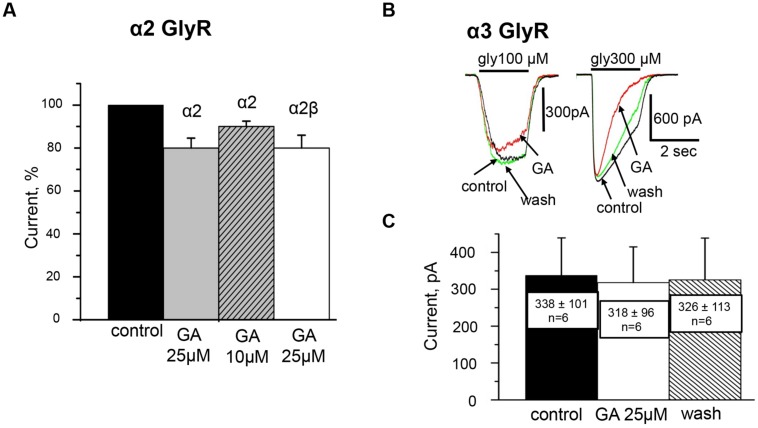
Effect of ginkgolic acid on Igly mediated by homomeric α2 and α3 GlyRs and heteromeric α2/β GlyRs.
(A) Cumulative data. Mean percentage of the effect of 25 μM ginkgolic acid on homomeric α2 GlyRs (light gray), heteromeric α2/β GlyRs (white colomn), and 10 μM of ginkgolic acid on α2 GlyRs (striped). Glycine 30 μM was applied. Data from 7 to 12 cells for each case. (B) Superimposed traces of glycine-evoked currents induced by low for this subunit (100 μM; left) and high (300 μM; right) concentrations of glycine, in control (black), after ginkgolic acid application (red) and after washout (green). Symmetrical ‘CsCl’ pipette solution, Vh = –30 mV. (C) Summary of the data on the effect of ginkgolic acid on the α3-long subunit of GlyR. Mean amplitudes of currents (pA) ± SEM induced by 100 μM glycine from six cells in control (black), during ginkgolic acid application (white), and after washout (striped).